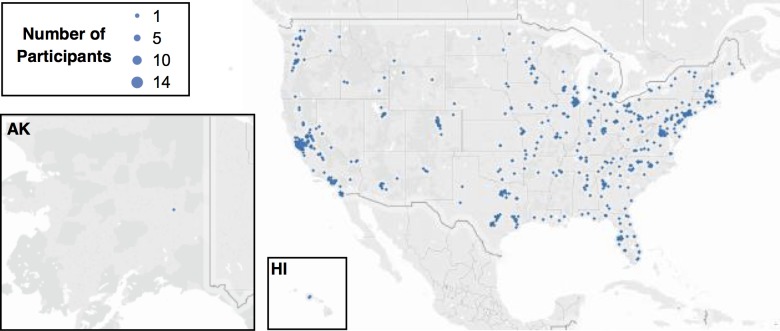
Geographical Distribution of Participants in the United States.Abbreviations: AK, Alaska; HI, Hawaii. Dots represent the number of participants that resided in the zip-code corresponding to the placement on the map. All 50 states were represented and 147 (23%) resided in California. Created with Tableau Software (www.tableau.com) and published with permission of the company (S1 File). The U.S. map was used under a CC BY-SA copyright from OpenStreetMap contributors (www.openstreetmap.org/copyright).